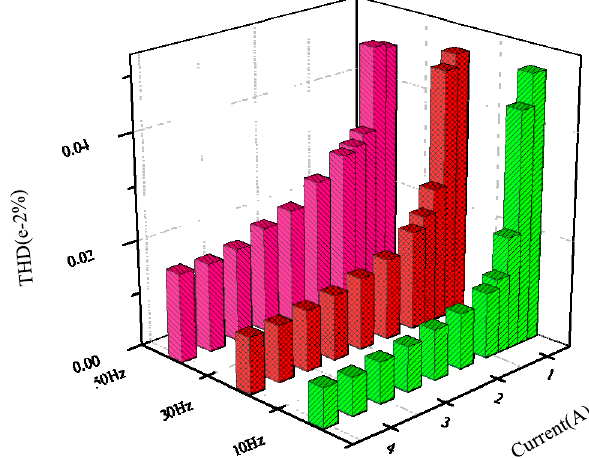
Figure 32. Changes of current THD according to frequency change of proposed